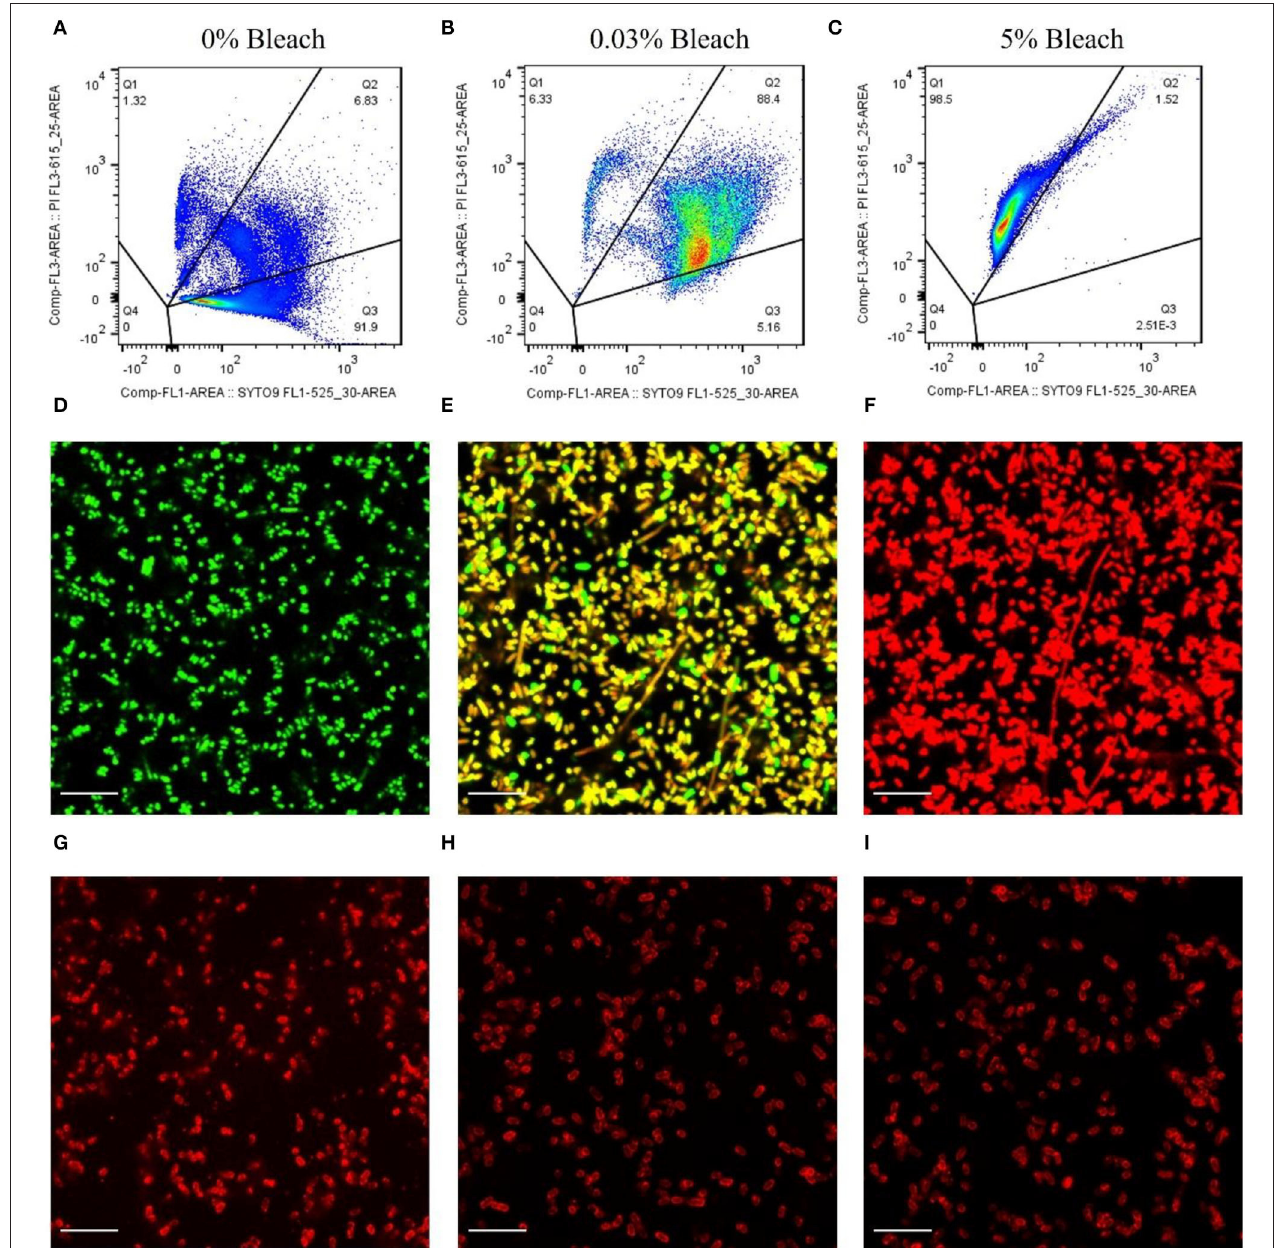
FIGURE 2 | Assessment of the binding ability of mCherry-Gp17 to E. coli cells in different viability states. (A–C) Representative flow cytometry plots showing the percentage of the dead (Q1), compromised (Q2), and viable (Q3) cells present after treatment with bleach at different concentrations. Cells were labeled with SYTO 9 (green) and PI (red). (D–F) Fluorescence microscopy images of E. coli cells treated with 0% bleach (viable), 0.03% bleach (compromised), and 5% bleach (dead) stained with SYTO 9 (green) and PI (red). (G–I) Fluorescence microscopy images of cells treated with 0% bleach (viable), 0.03% bleach (compromised), and 5% bleach (dead) after incubation with